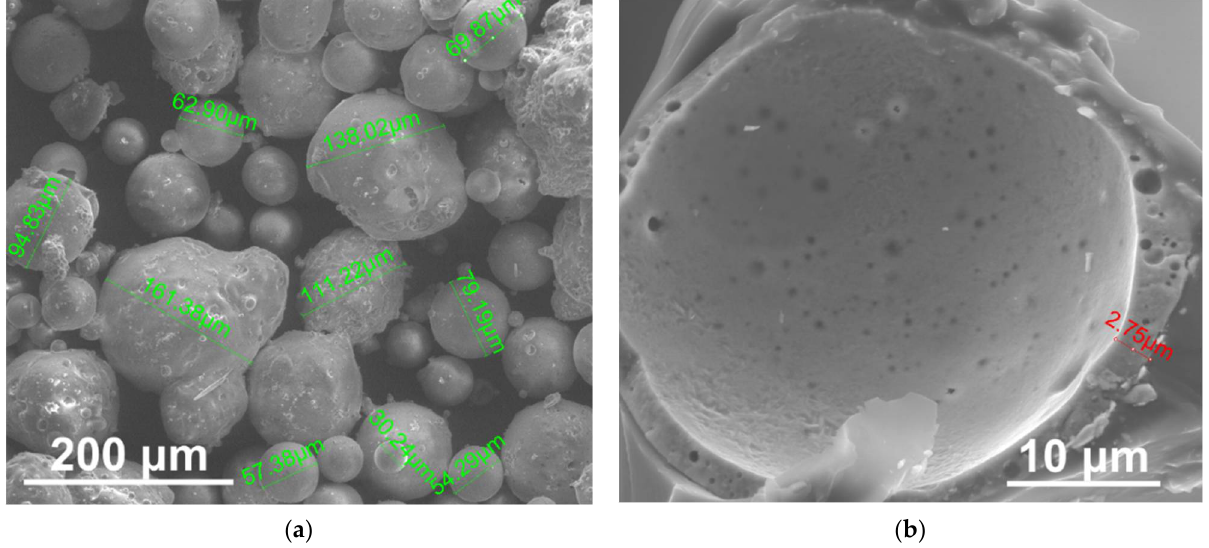
Figure 2. SEM images of different sizes of M ( a ) and broken M ( b ). Magnitudes×350 ( a ), and ×5000 ( b ).